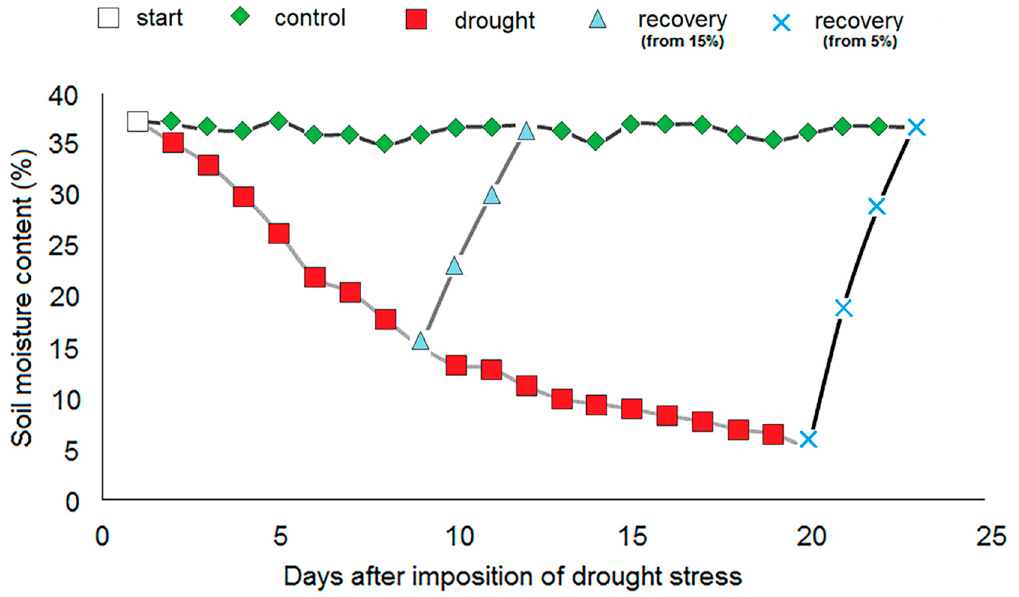
Figure1. Changesinsoilmoisturecontentafterimpositionofdroughtstressforcontrol, drought-stressed Figure 1. Changes in soil moisture content after imposition of drought stress for control, drought- and recovery group of I. walleriana stressed and recovery group of I. walleriana.